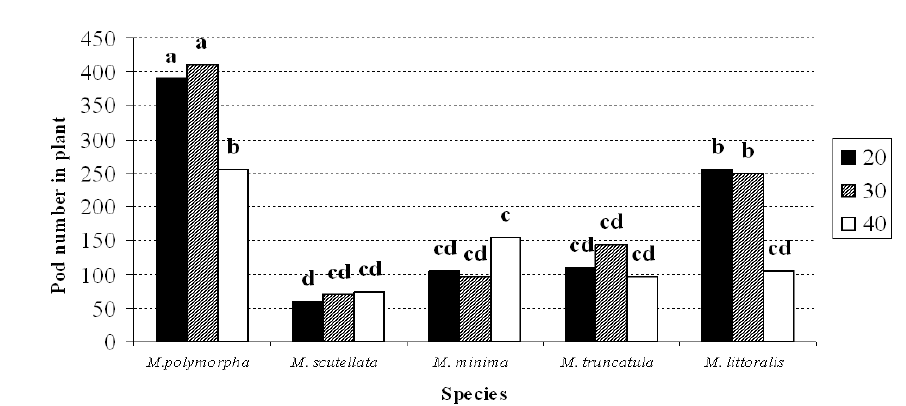
Fig. 9. Interaction effect between species and within row spacing on pod number in plant. All the values followed by the same letter in each column are not statistically different at the p<0.05